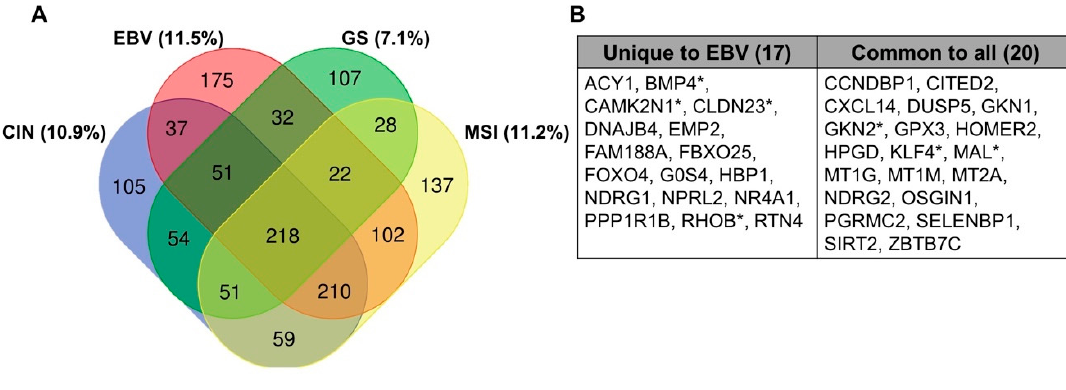
Figure 2. Down-regulated genes via mRNA-sequencing from the Cancer Genome Atlas dataset in gastric cancer subtypes. ( A ) Shown with percent of total genes that are known TSGs, identified from the TSGene Database. ( B ) TSGs listed that are unique to the EBV-infected subtype compared to those that are common to all subtypes. Asterisk indicates genes further described in Tables 2 and 3.